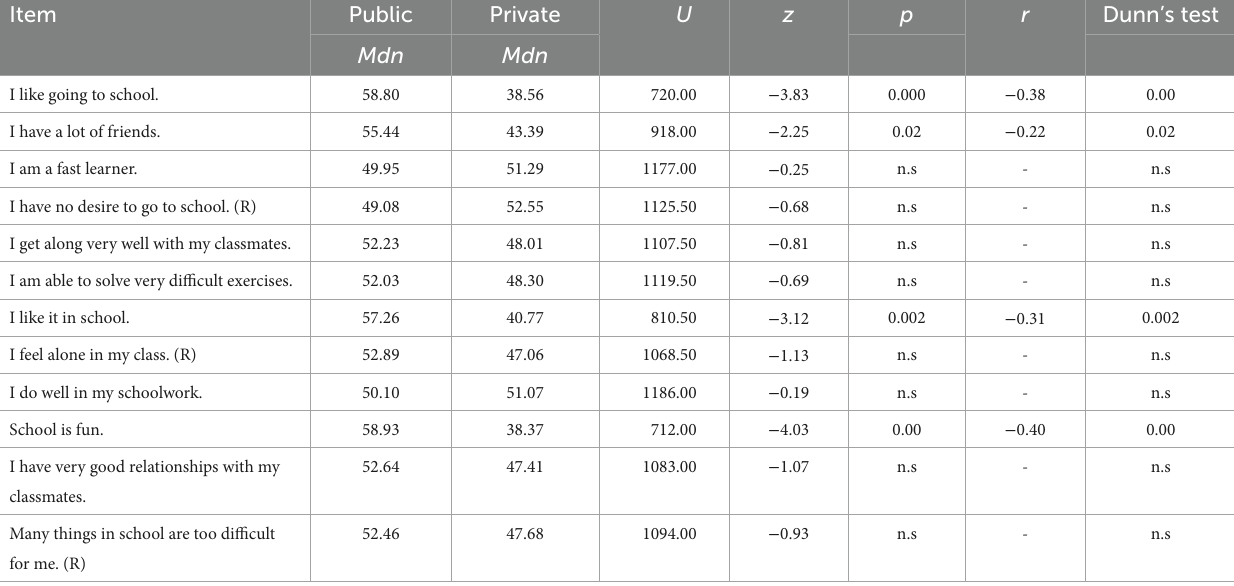
TABLE 4 Medians, Mann–Whitney U and Dunn’s tests by sample and effect size ( N = 101).